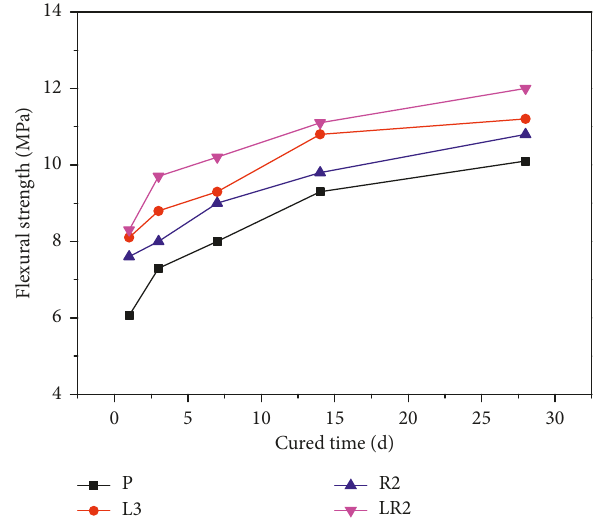
Figure 10: Flexural strength of cement slurry with curing time.